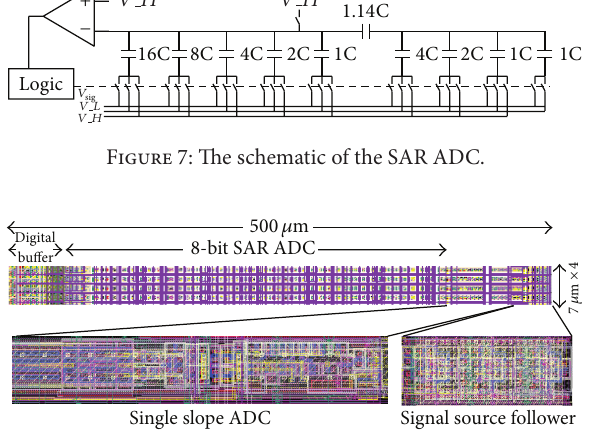
Figure 8: The fabricated chip layout of the proposed ADC.